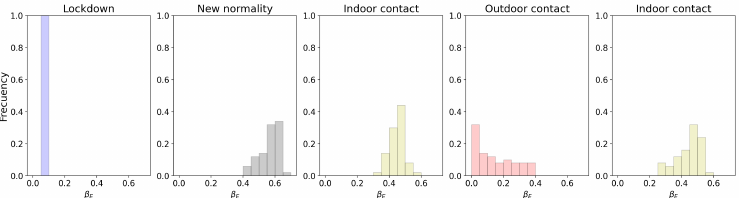
Figure 19. Histogram of the 50 different provinces of Spain. The value of β E at the different levels of lockdown registered in